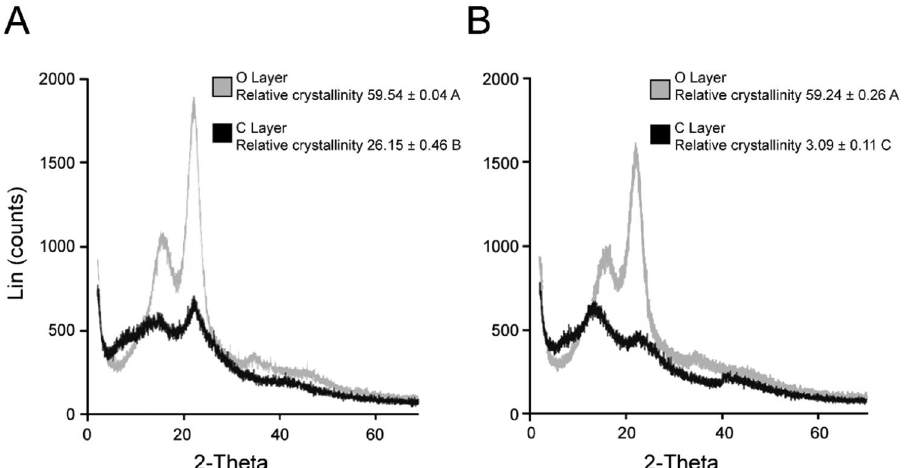
Figure 2. Cellulose crystallinity is reduced as a result of charring. The crystallinity of cellulose in the C layer and the O layer was measured by X-ray scattering in a new barrel ( A ) and a ten-year-old barrel ( B ). The C layer of both barrels shows a significant reduction in relative crystallinity. The relative crystallinity of the O layer was similar in both the new barrel and the ten-year-old barrel, whereas the crystallinity of the C layer was significantly lower in the ten-year-old barrel (Tukey-Kramer multiple comparison test, P < 0.05, n = 3; different letters denote significant